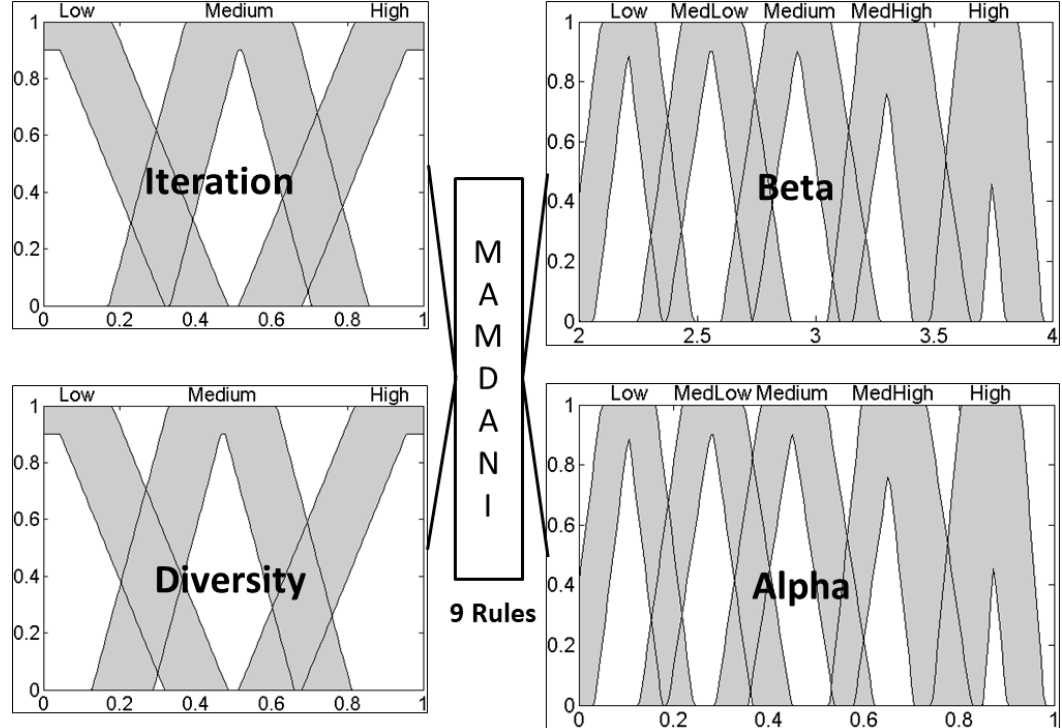
Figure 2. Interval type-2 fuzzy system for dynamic parameter adaptation in BCO.